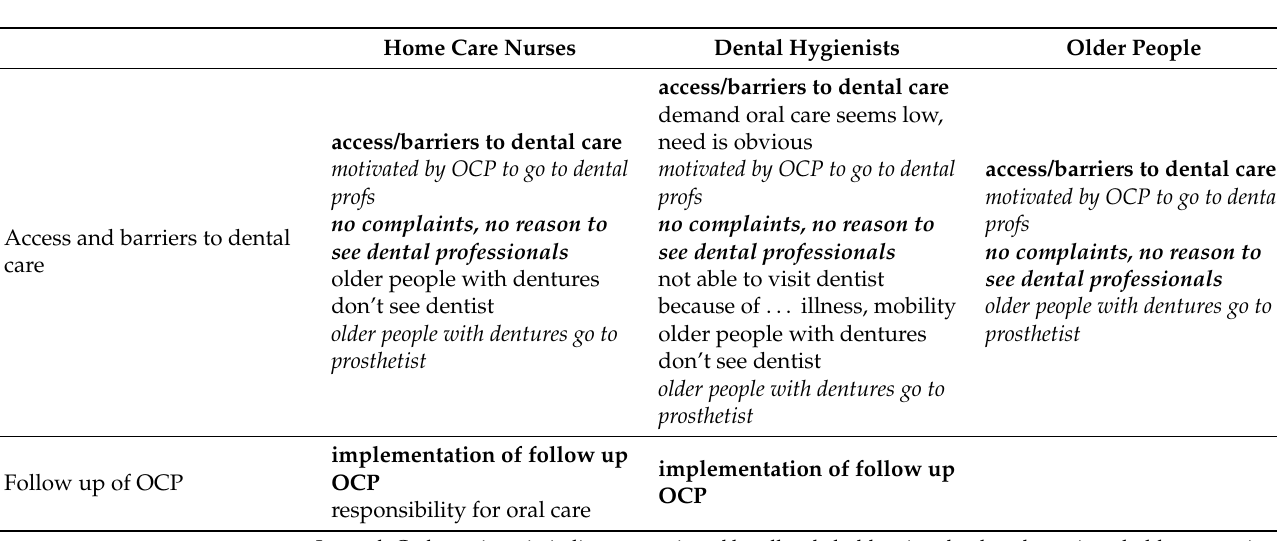
Table 1. Cont. Home Care Nurses Dental Hygienists Older